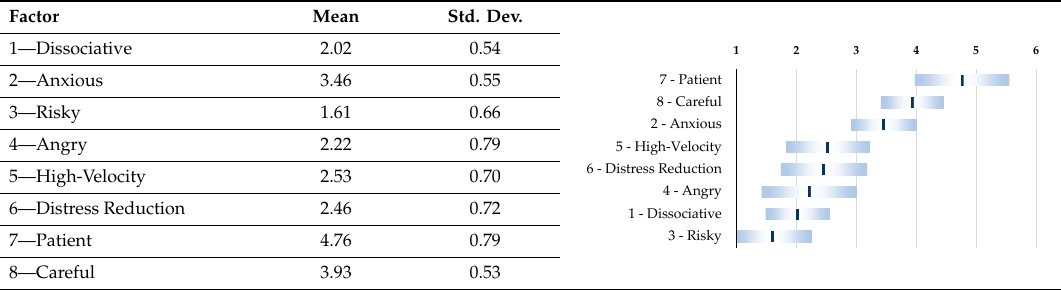
Table 6. Correlation (R) among driving styles. The background indicates the level of correlation between the variables: blue is positive, ochre is negative. Color saturation indicates the magnitude of the correlation.